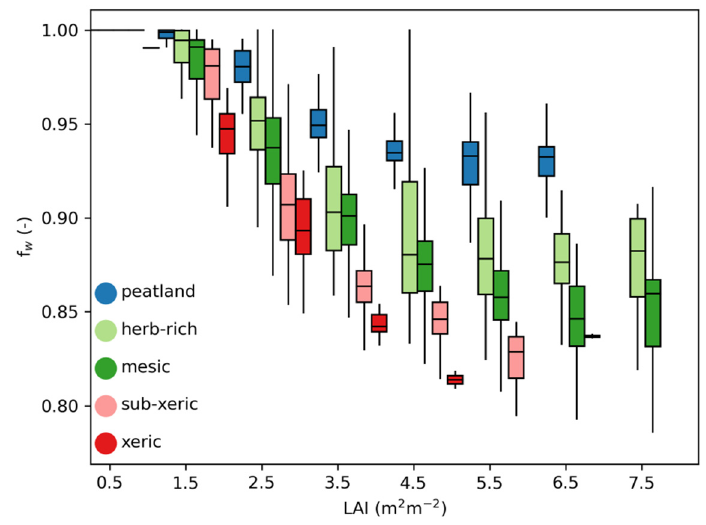
Figure 9. Soil moisture modifier for transpiration ( f w , Figure 7a), a proxy of limited soil moisture availability, as a function of site type and stand leaf-area index (LAI). The 16 × 16 m model predictions were averaged to LAI-bins of 1 m 2 m − 2 width and shifted slightly within a bin to avoid overlap of the boxplots. The horizontal black lines show median, box boundaries the IQR and whiskers 1st/99th percentiles.